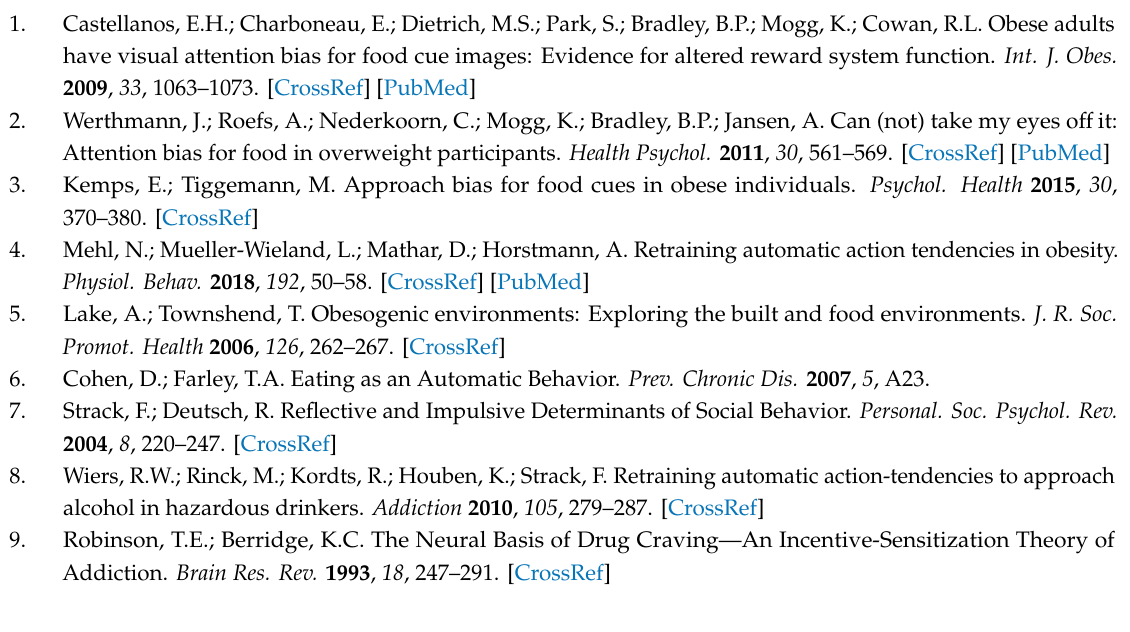
Table S1: Questionnaire di ff erences between the training and no-training groups; p -values reflect significance of group di ff erences; Table S2: Ratings of healthy and unhealthy images used in the AAT paradigm for healthiness and liking on a scale from 0 to 10; Table S3: Picture-sorting task—ratings of healthy and unhealthy images on healthiness and liking on a scale from 0 to 10. We observed no significant group di ff erences. Author Contributions: Conceptualization, N.M., F.M., and A.H.; Data curation, N.M. and F.M.; Formal analysis, N.M., F.M., A.V., and A.H.; Investigation, N.M. and F.M.; Resources, A.V.; Supervision, A.H.; Visualization, N.M. and F.M.; Writing—original draft, N.M. and F.M.; Writing—review and editing, A.V. and A.H. Funding: N.M. was supported by MaxNetAging Research School. The work of F.M. and A.H. is supported by the Integrated Research and Treatment Center Adiposity Diseases at the University of Leipzig. The work of A.H. and A.V. is supported by the Collaborative Research Centre 1052 ‘Obesity Mechanisms’, subproject A5, at the University of